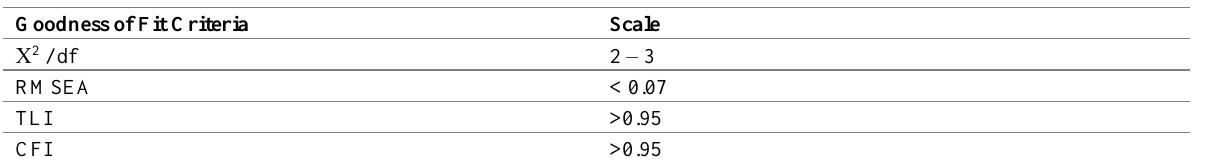
Table 1 : Goodness of Fit